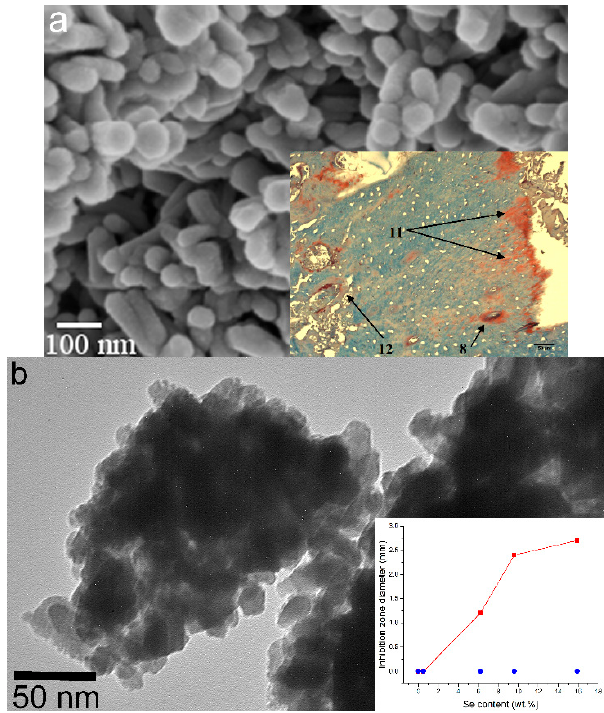
Figure 5. ( a ) SEM image of hydroxyapatite nanoparticles in which Ca 2+ ions were partially substituted with Co 2+ ions. The inlet shows an almost complete resorption of the implant and the regeneration of an osteoporotic bone 24 weeks after the implantation (8—formation of Haversian canals; 11—ossification frontline; 12—collagen fibers; all in-between is the region filled by the newly regenerated bone); ( b ) TEM image of selenite-incorporating hydroxyapatite nanoparticles. The inlet shows the diameter of E. coli growth inhibition zone around particles of selenite-doped hydroxyapatite as a function of the concentration of selenite ions inside hydroxyapatite particles and depending on whether the selenite ions were incorporated into the lattice by co-precipitation (- ■ -) or by ion-exchange sorption (- ● -).